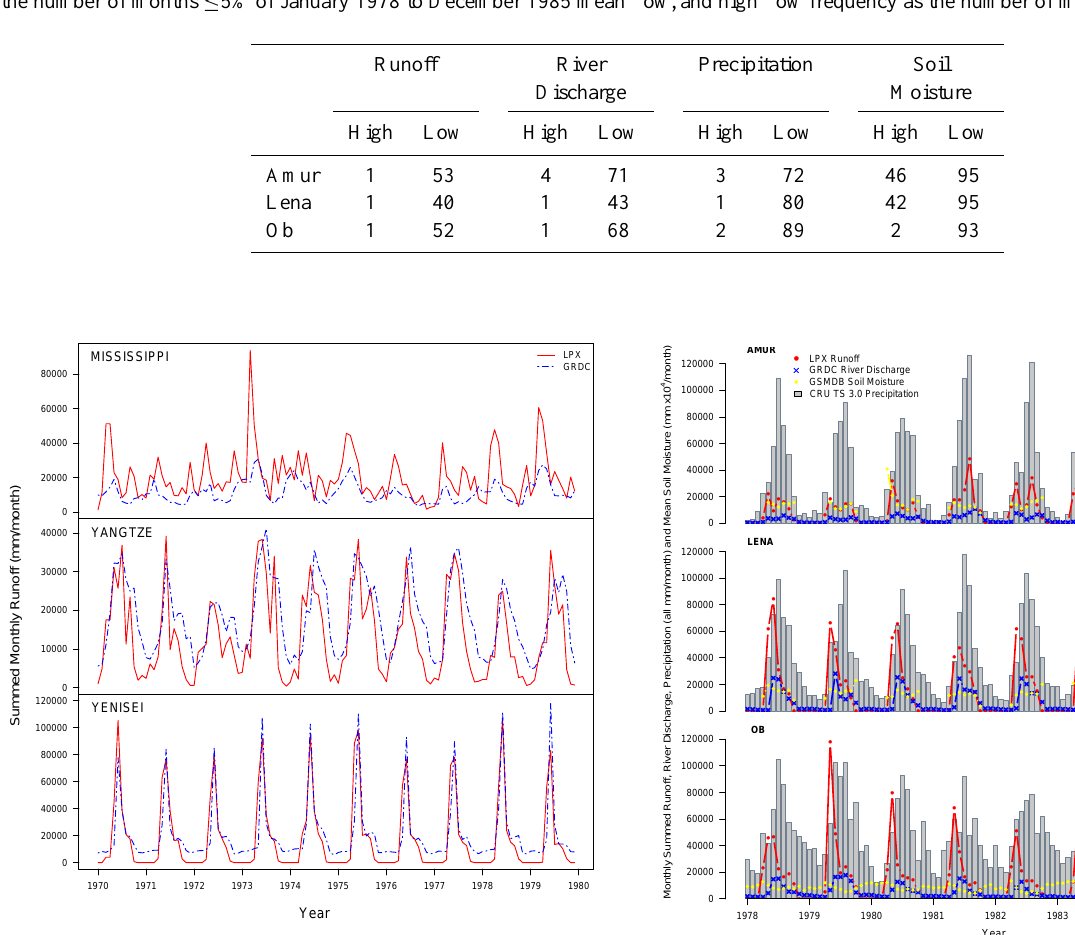
Fig. 7. Total summed monthly catchment LPX runoff versus GRDC runoff equivalent river discharge for the Mississippi, Yangtze and Yenisei catchments (1970–1979).